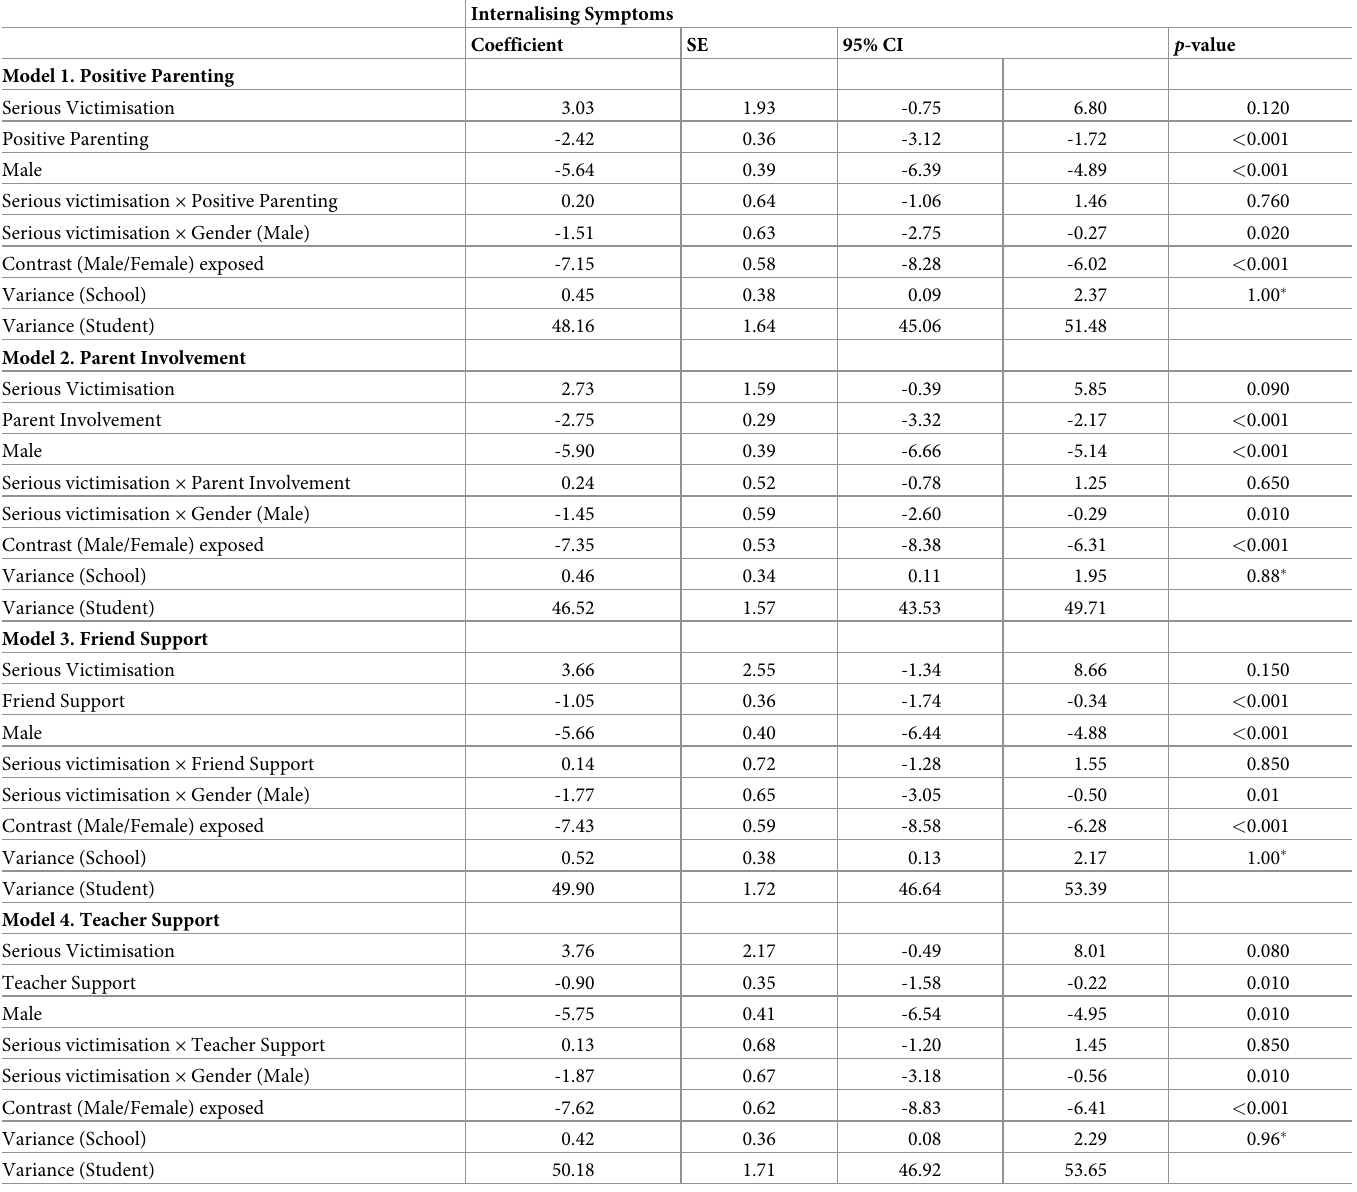
Table 3. Linear mixed-effects models of serious victimisation, type of social support & interactions